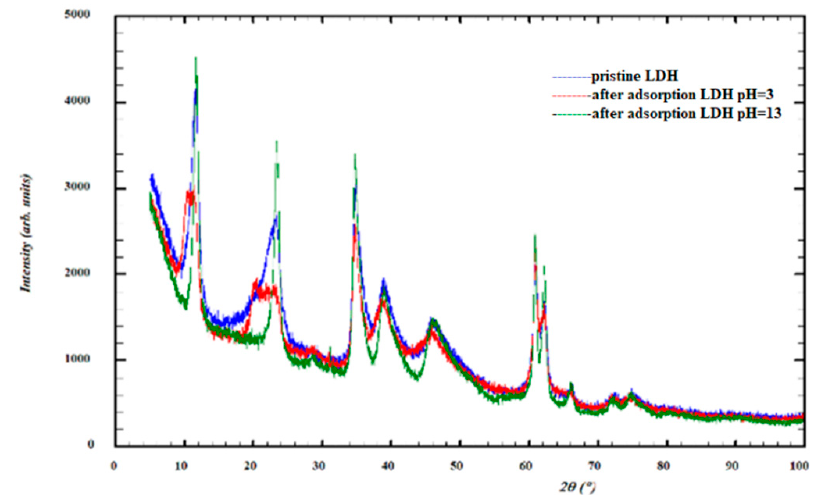
Figure 7. PXRD patterns of the pristine MgAl-NO 3 LDH (blue line) after Cr(VI) extraction at pH = 3 (red line) and pH = 13 (green line).